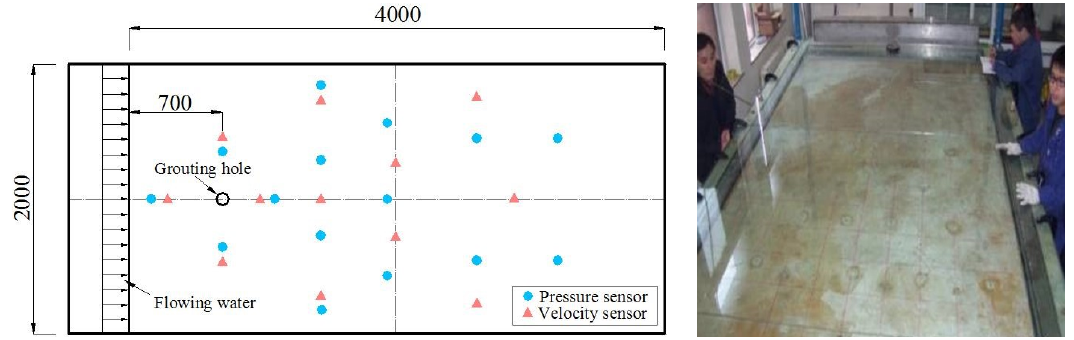
Figure 4. Fracture platform and sensor